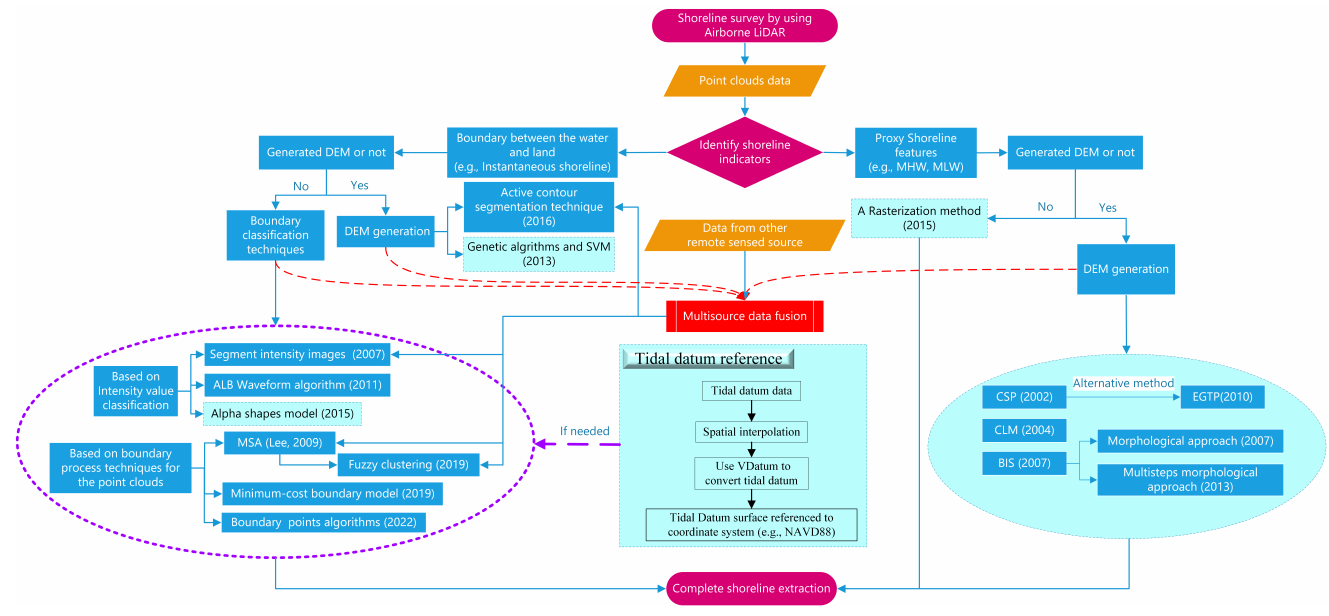
Figure 2. Flow diagram of the mainstream shoreline extraction method. Notes: The dark cyan box indicates that it is necessary to refer to tidal data during the process of shoreline